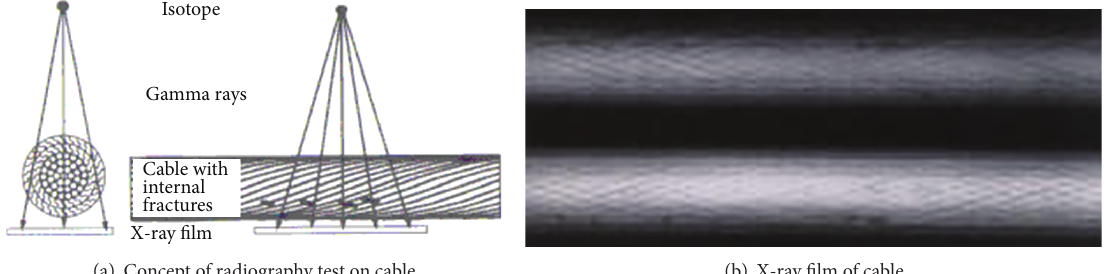
Figure 9: Radiography inspection for bridge cable inspection